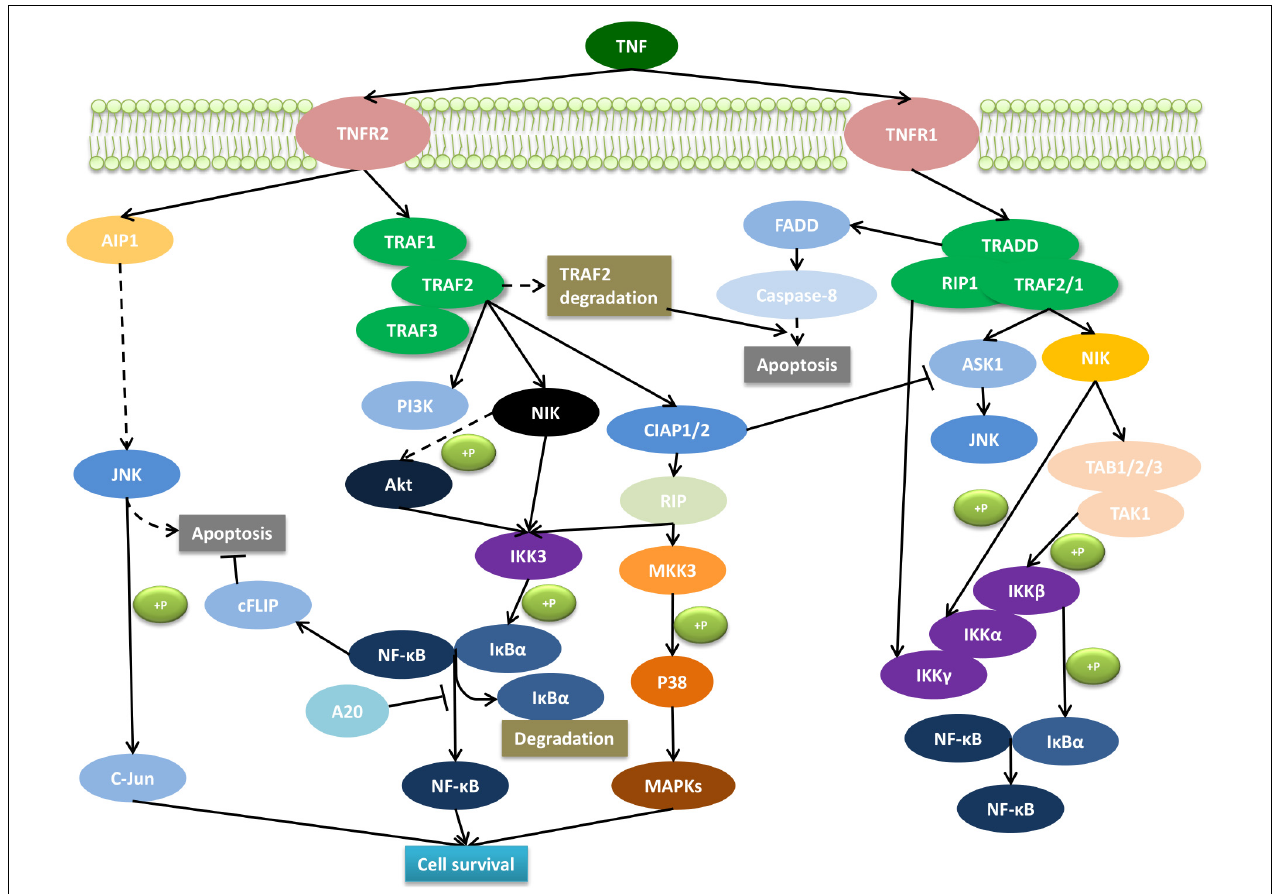
FIGURE 1 | Molecular signaling pathway of TNFR2. The interaction of the membrane form of TNF with TNFR2 promotes cell survival through the activation of the complex signaling cascade. AIP1, ASK interacting protein 1; Akt, serine–threonine kinase; ASK1, apoptosis signal-regulating kinase 1; cFLIP, caspase-8 homolog FLICE-inhibitory protein; cIAP, cellular inhibitor of apoptosis protein; FADD, Fas-associated death domain protein; IKK, I κ B kinase; I κ B α , inhibitor of kappa B; JNK, c-Jun N-terminal kinase; NF κ B, nuclear factor kappa B; MAPKs, phosphorylate mitogen-activated kinase; MKK, mitogen-activated protein kinase kinase; NIK, NF κ B-inducing kinase; PI3K, phosphoinositide 3-kinases; RIP, receptor interacting protein; TRADD, TNF receptor-associated death domain; TRAF, TNF receptor-associated